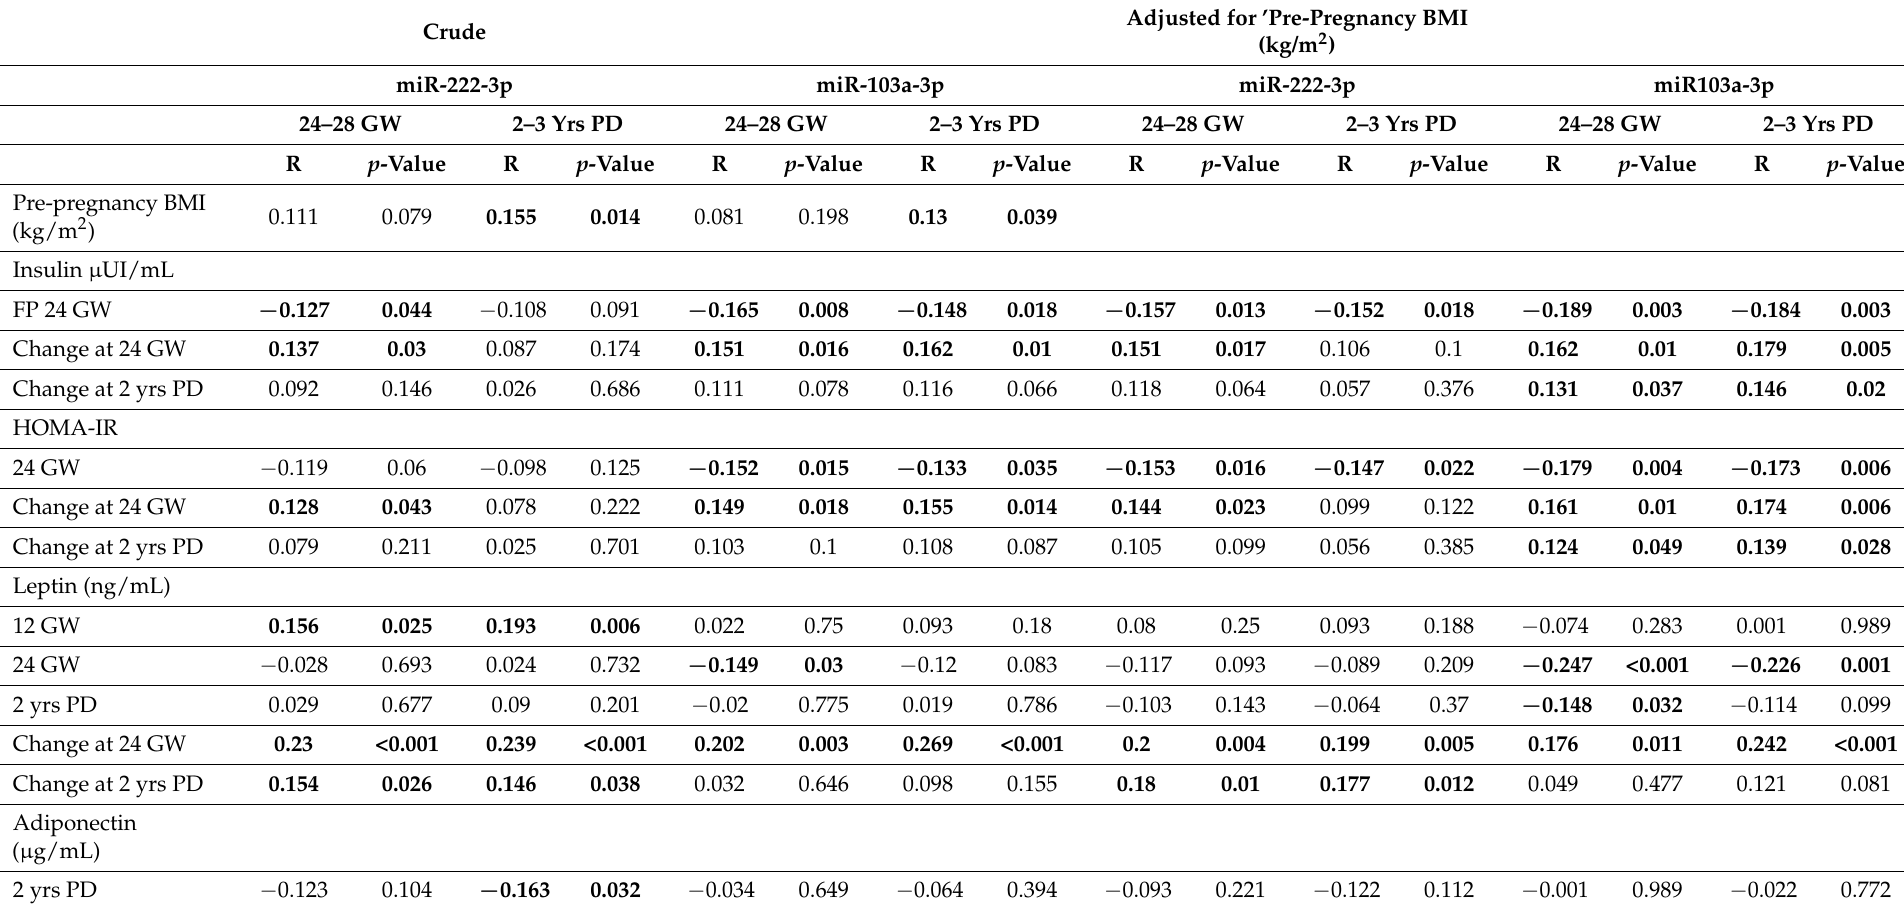
Table 7. Statistically significant correlations of miR-222-3p and miR-103a-3p with insulin, HOMA-IR, adipokines and